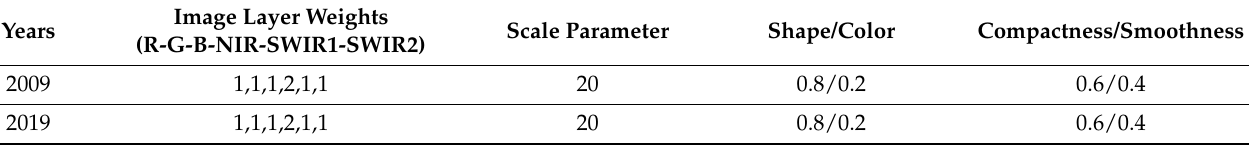
Table 1. Segmentation values.